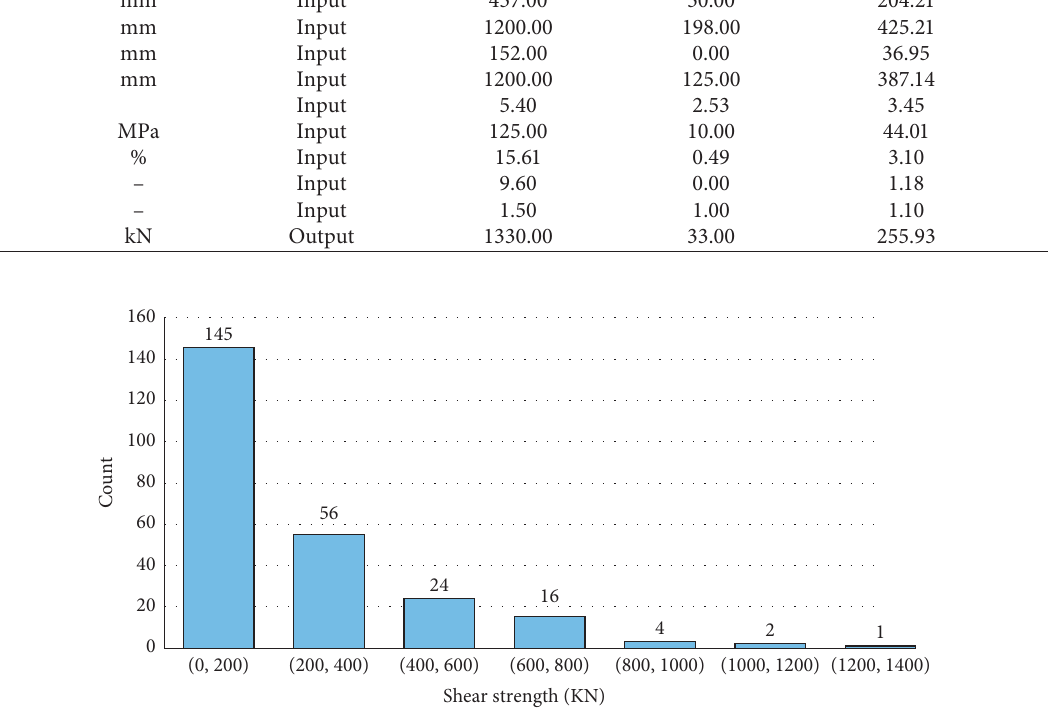
Figure 4: Shear strength distribution of experimental